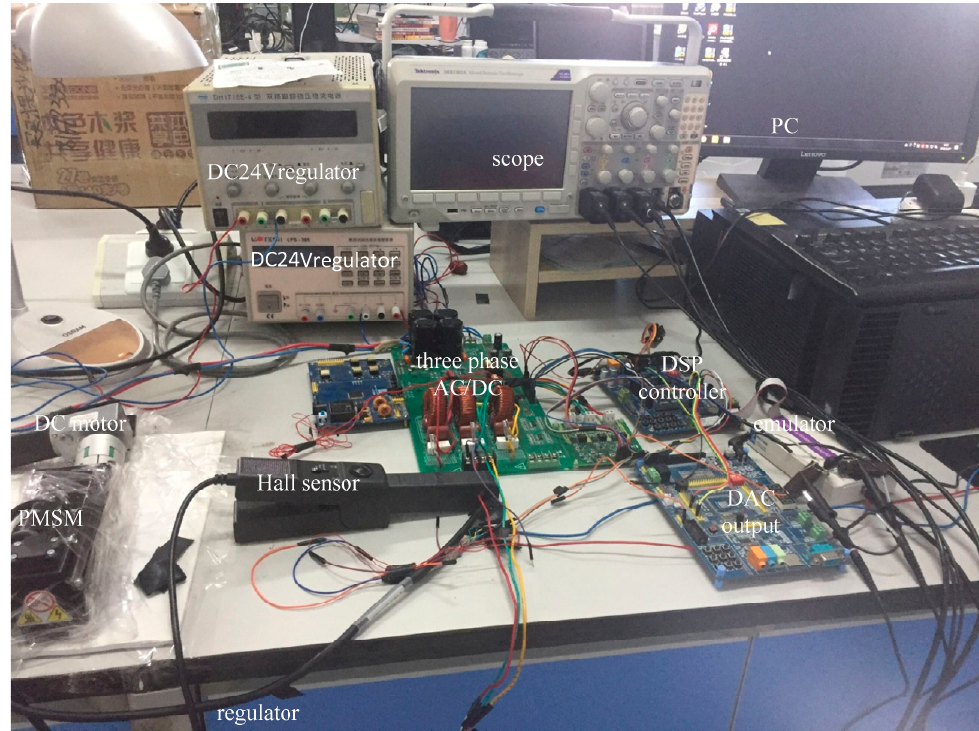
Figure 4. Hardware design of the permanent magnet synchronous motor control system based on DSP. Table 1. Nominal SPMSM Parameters.